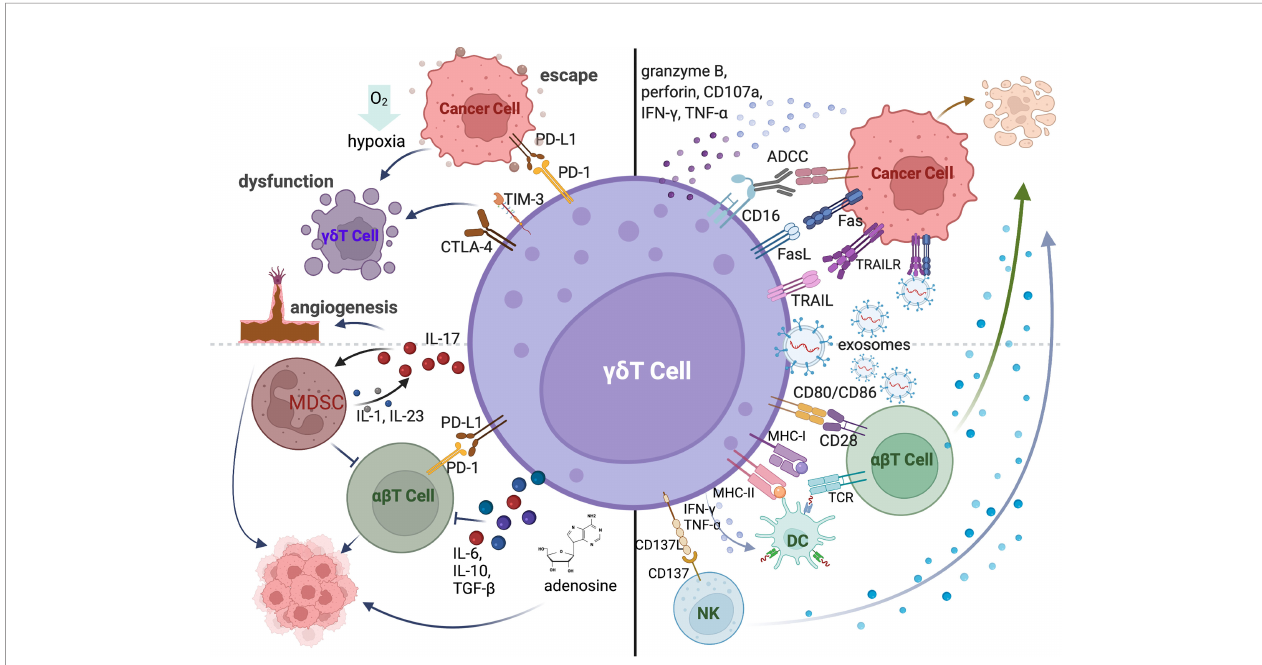
FIGURE 2 | The anti-tumor and pro-tumor functions of gd T cells mediated by cytokines and receptor-ligand interactions. gd T cells can directly kill tumor cells by expressing death receptor ligands (FasL, TRAIL), producing cytotoxic molecules (granzyme B, perforin, CD107a, IFN- g and TNF- a ) and mediating ADCC via CD16 expression. The exosomes derived from gd T cells can also directly induce the apoptosis of cancer cells. gd T-APC can activate conventional T cells via MHC-I, MHC- II, and co-stimulatory molecules. gd T cells induce the maturation of DCs by secreting IFN- g and TNF- a and trigger the activation of NK cells via CD137L. The pro- tumor function of gd T cells is mediated by the expression of co-inhibitory receptors. The co-inhibitory molecules contribute to tumor cell escape from immune surveillance. Hypoxic tumor microenvironment also induces the dysfunction of gd T cells. gd T cells also promote the tumor growth by recruiting immunosuppressive cells and inhibiting conventional T cells via producing IL-17, IL-6, IL-10, TGF- b or